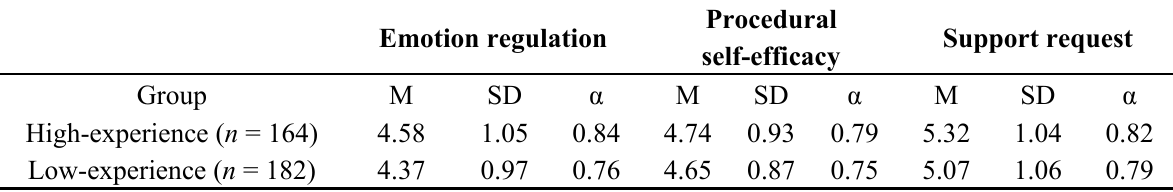
Table 4. Descriptive statistics and reliability for social workers with high and low work experience, second-split sample ( n =